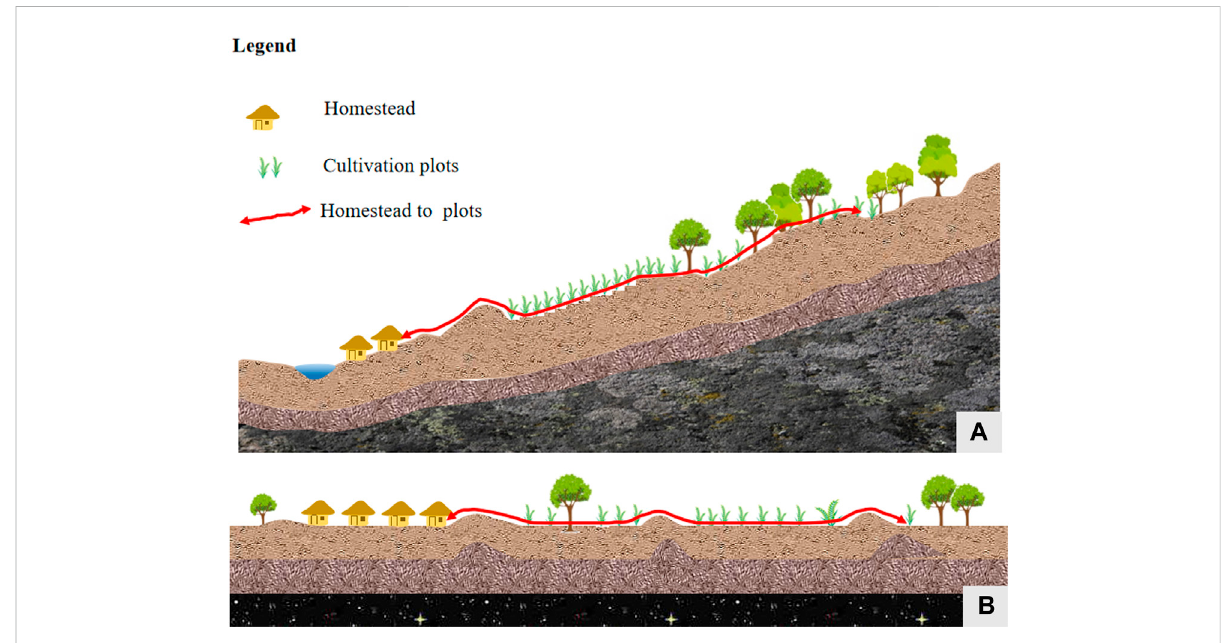
FIGURE 1 Schematic diagram of the distribution of homesteads and plots. Figure 1A shows that the road network is affected by the topography in the mountainous areas. Figure 1B shows the road network in a fl at